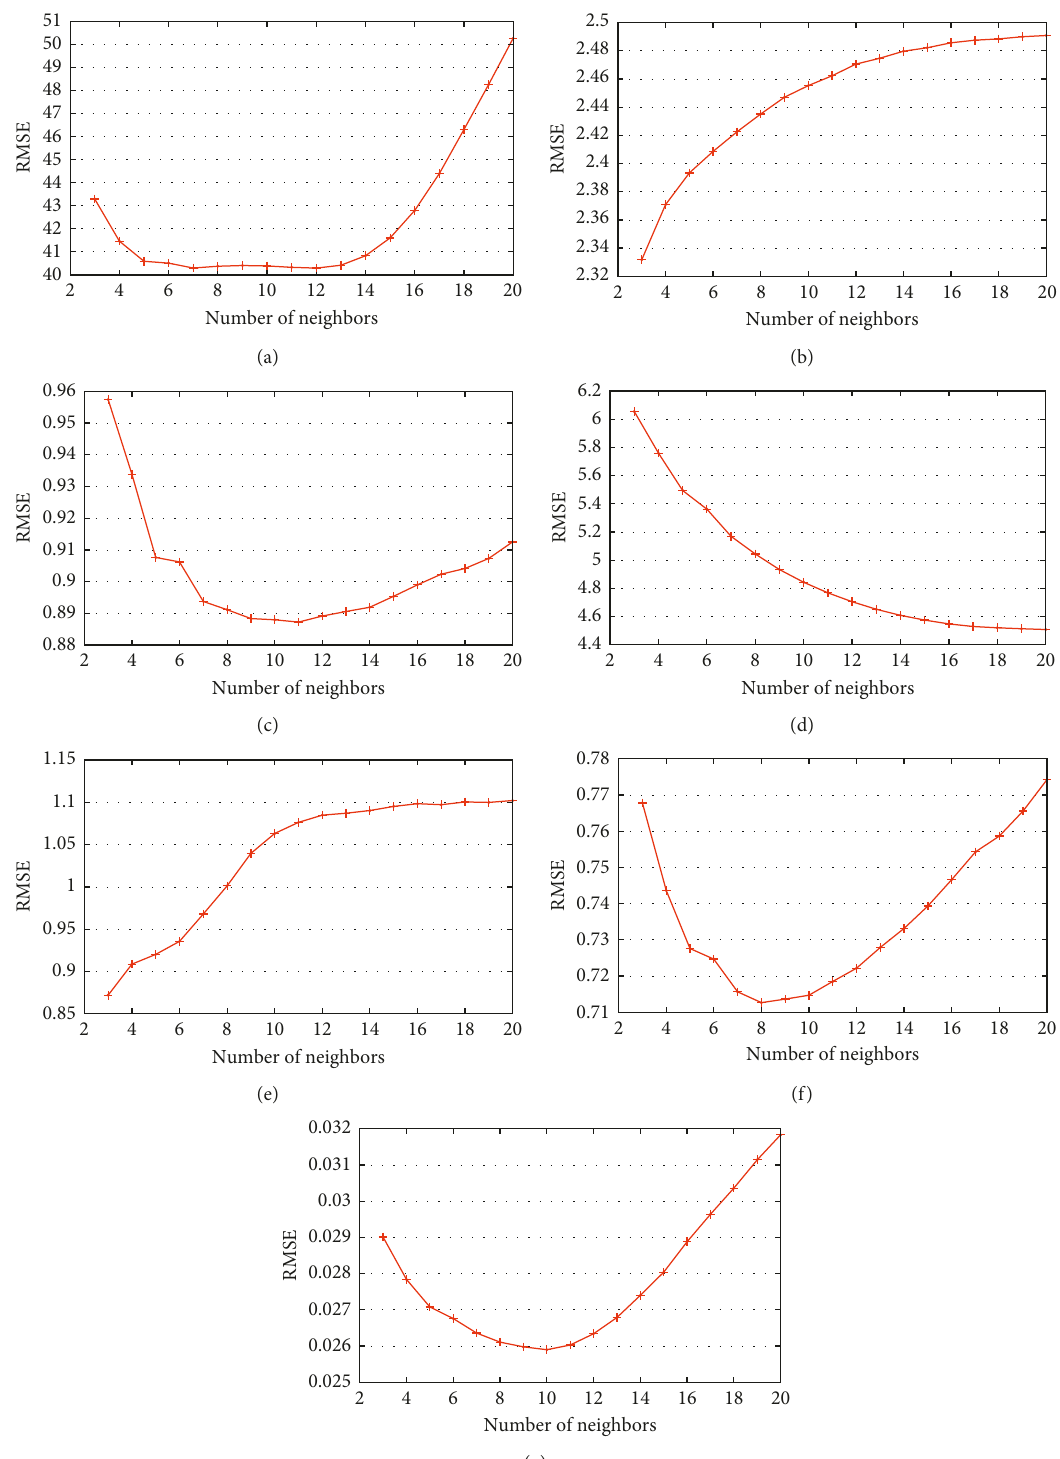
Figure 7: Accuracy of estimates according to the number of selected neighboring stations (RMSE). (a) Wind direction. (b) Wind speed. (c) Temperature. (d) Humidity. (e) Atmospheric pressure. (f) Precipitation. (g) Rainfall